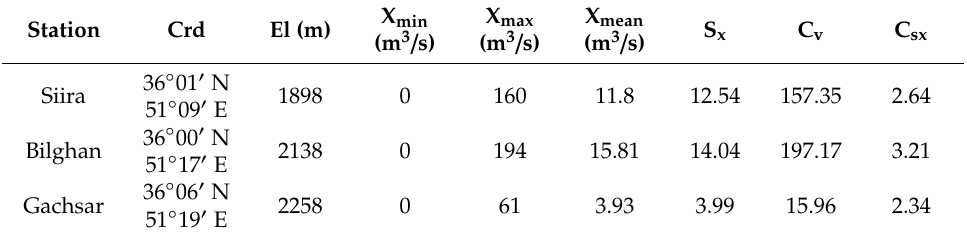
Table 1. Descriptive statistics of river flow data for the study site located at the Karaj basin.